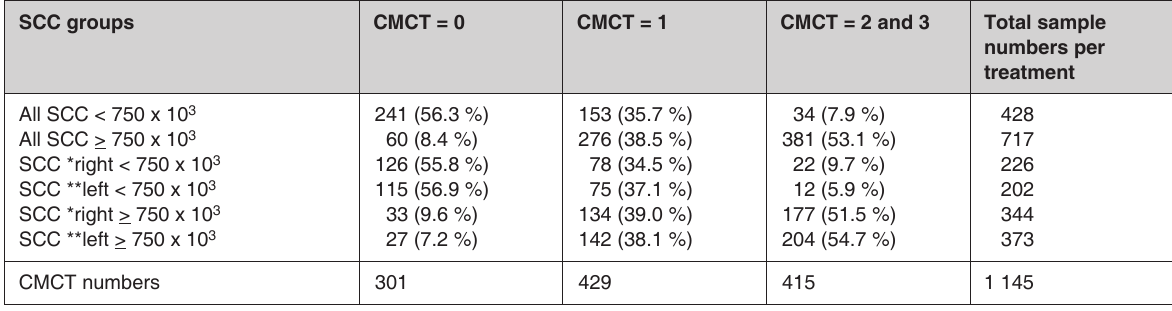
TABLE 3 The association between somatic cell counts (SCC) and California Milk Cell Test (CMCT) ratings (%) for milk goats SCC